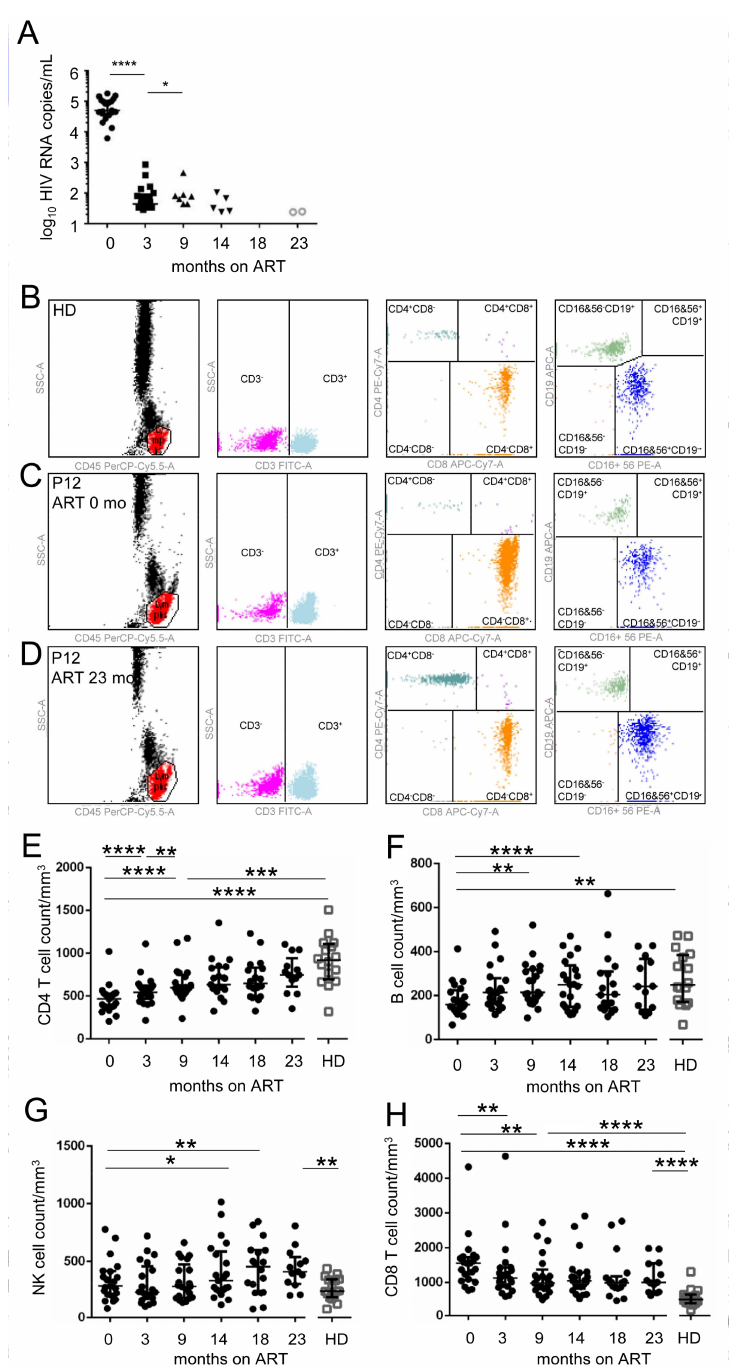
Figure 1. Adaptive immunity is only partially restored over the course of ART despite the sustained suppression of HIV-1 RNA level. Characteristics of the cohort of 21 HIV-infected subjects. ( A ) HIV RNA copies/mL of plasma before and during anti-retrovirus therapy (ART). ( B – D ) Dot plots for the quantification of the major lymphocyte populations in peripheral blood of a healthy donor (HD) ( B ), treatment-naïve patient no. 12 (P12) ( C ), the same patient after 23 months of ART ( D ). ( E ) CD3 + CD4 + T cell counts during ART. ( F ) CD19 + B cell counts during ART. ( G ) CD3 − CD16 + CD56 + NK cell counts during ART. ( H ) CD3 + CD8 + T cell counts during ART. The data show medians and interquartile range, N = 21. * p < 0.05; ** p < 0.01; *** p < 0.001; **** p < 0.0001; two-tailed paired Wilcoxon